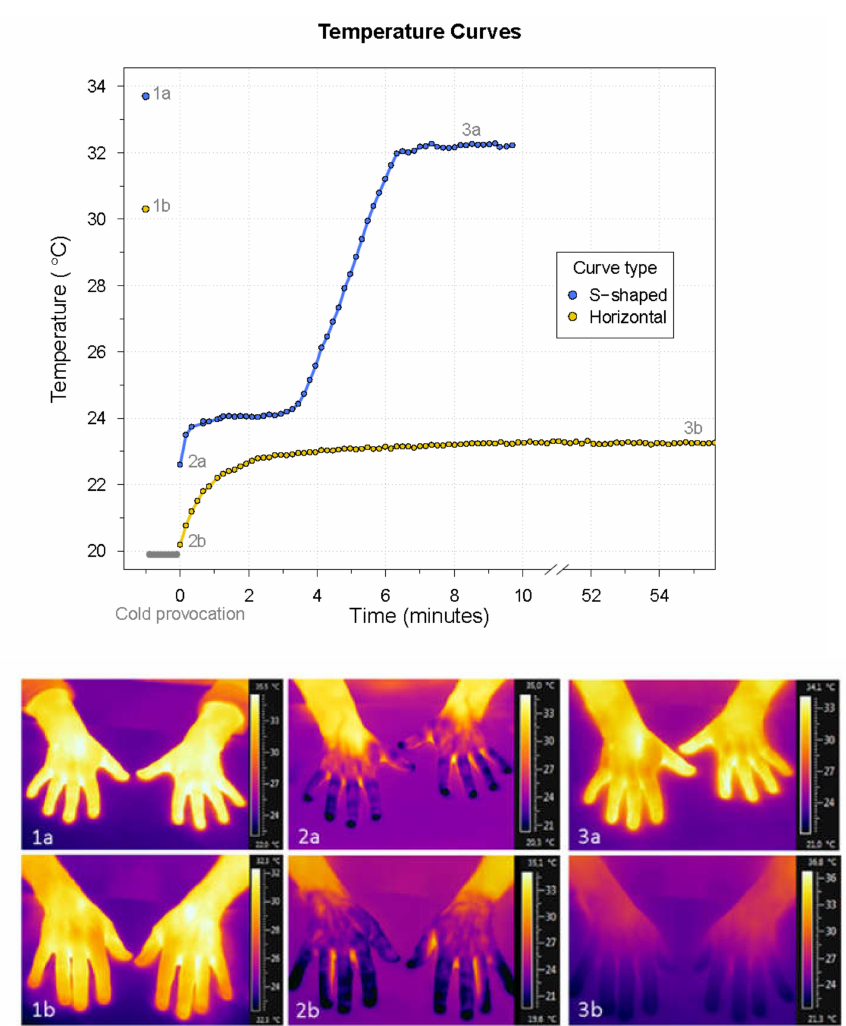
Figure 1. The two curve types identified during the analysis of the thermographic temperature curves. The numbers 1–3 refer to the time points of the baseline, immediately after cooling, and at the end of the thermographic examination, respectively. These time points correspond to the temperature variables baseline finger temperature (t base ), finger temperature immediately after cooling (t nul ), and end temperature (t end ), respectively. The thermographic images associated with the mentioned time points are shown below the curves. The top bar shows the hands of a healthy individual ( a ), while the bottom bar presents the hands of a patient with RP ( b ). This figure is reproduced from the study, describing the recently developed algorithm